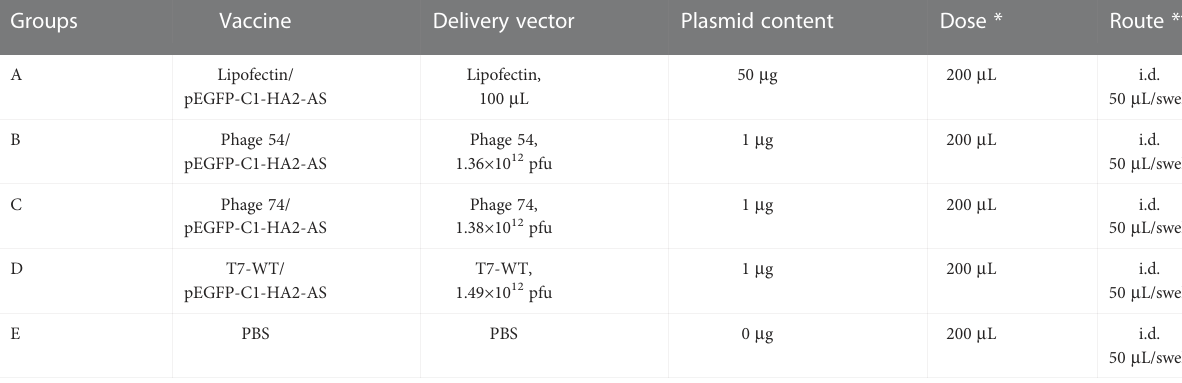
TABLE 1 Immunization strategy for the different chicken groups.